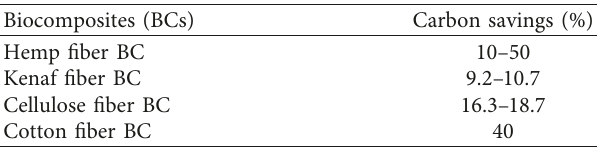
Table 17: Biocomposites with their percentage of carbon savings [160]. Biocomposites